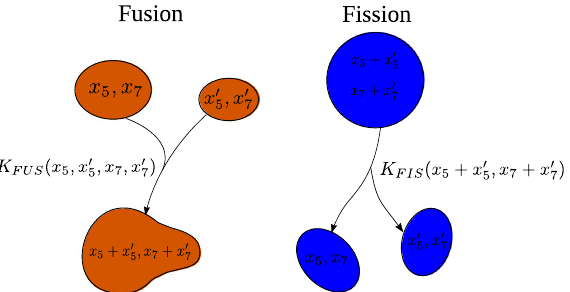
Figure 2. Fusion and fission events depend on the number of Rab5 and Rab7 molecules, not their concentration. Left: two endosomes with different levels of active Rab5 and Rab7, ( x 5 , x 7 ) and ( x ′ 5 , x ′ 7 ) , respectively, merge into a new endosome with levels of active Rab5 and Rab7, ( x 5 + x ′ 5 , x 7 + x ′ 7 ) , with rate K FUS ( x 5 , x ′ 5 , x 7 , x ′ 7 ) . Right: an endosome with levels of active Rab5 and Rab7 ( x 5 + x ′ 5 , x 7 + x ′ 7 ) splits into two new endosomes with levels of active Rab5 and Rab7 ( x 5 , x 7 ) and ( x ′ 5 , x ′ 7 ) , respectively, with rate K FIS ( x 5 , x ′ 5 , x 7 , x ′ 7 )